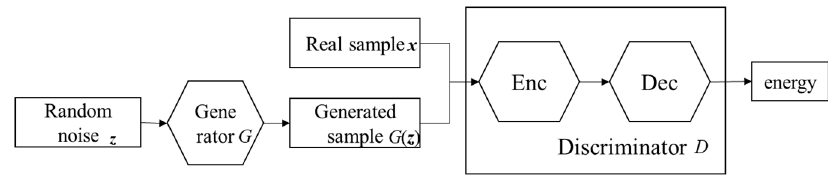
Figure 5. Architecture of the energy − based generative adversarial network.